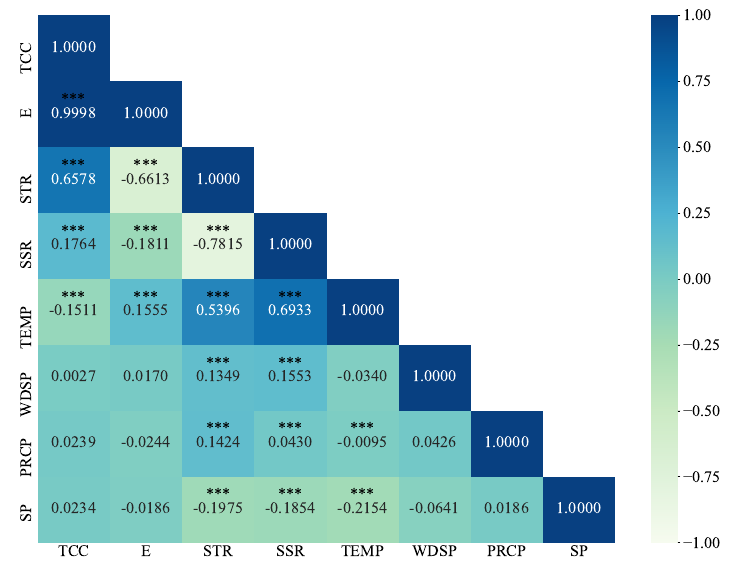
Figure 7. The heat map of the partial correlation coefficient between climate variables. *** means that the p -value is less than 0.05.